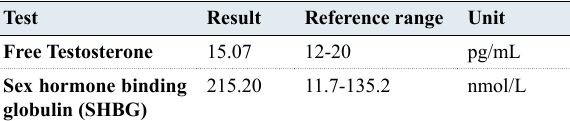
Table 2: Laboratory finding of free testosterone and